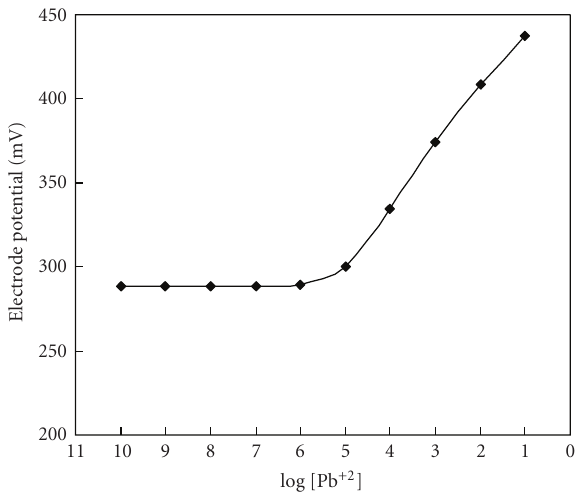
Figure 6: Calibration curve of poly-o-anisidine Sn(IV) arsenophos- phate membrane electrode in aqueous solutions of Pb(NO 3 ) 2 .